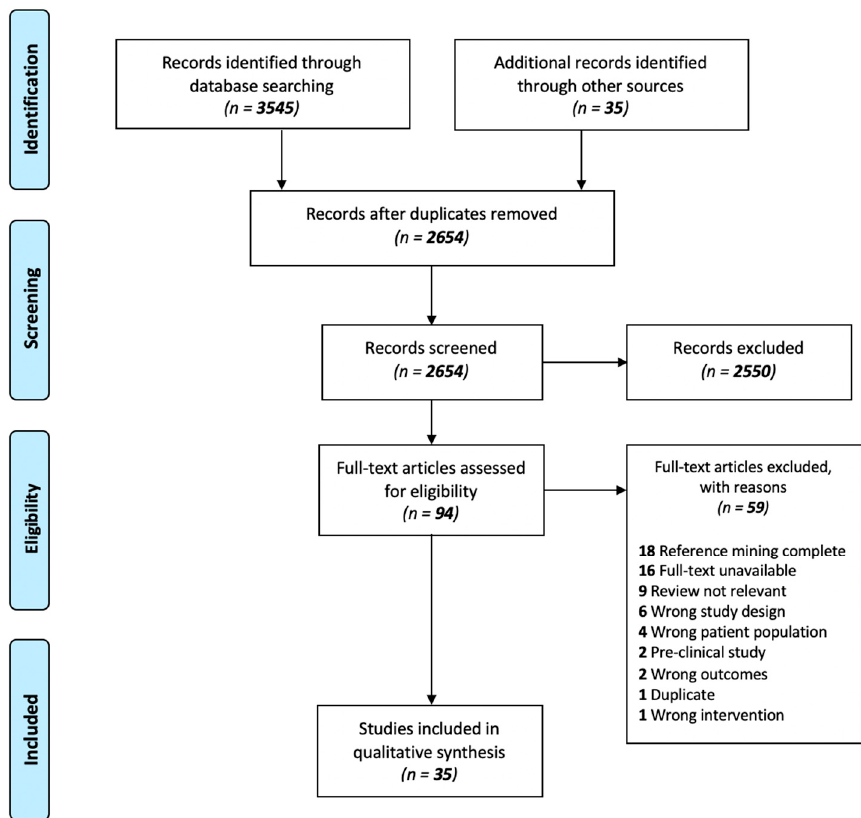
Figure 2. Preferred reporting items for systematic reviews and meta-analyses (PRISMA) flowchart. Literature search and selection process of included studies.